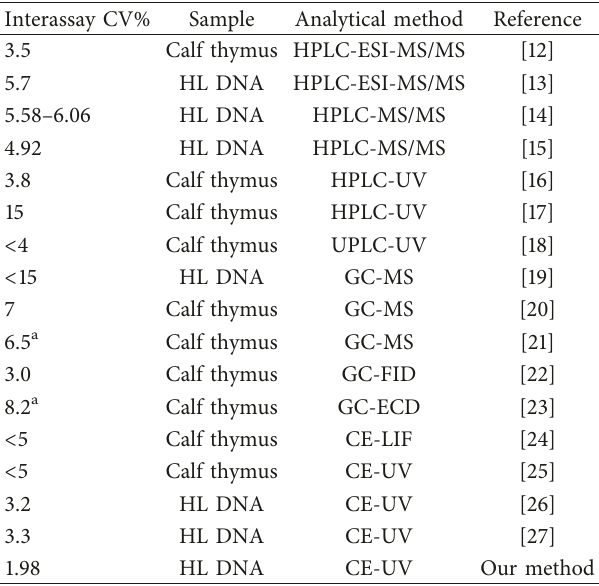
Table 1: Interassay precision of the quality control samples calf thymus DNA or human leukocyte (HL) of our CE method com- pared to other published values.